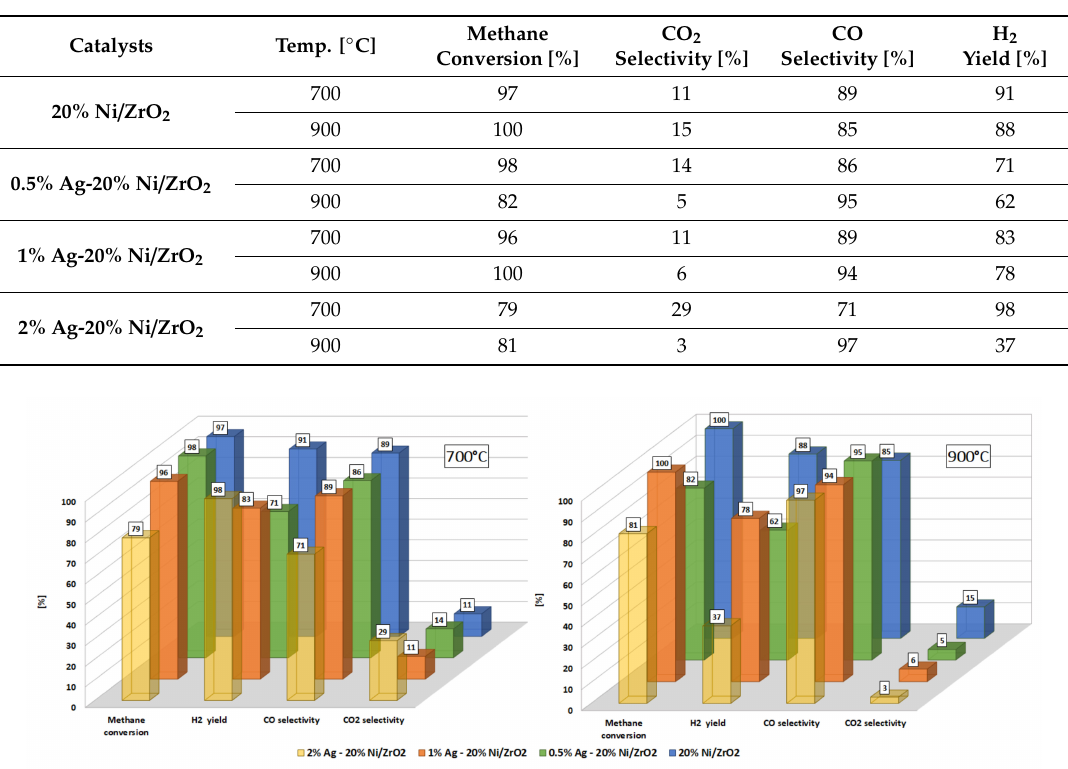
Table 1. Methane conversion, hydrogen yield and selectivity values towards CO and CO 2 formation in